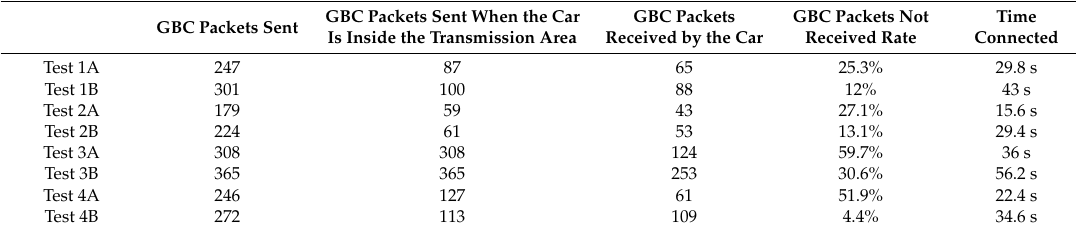
Table 3. Packets sent and received in the